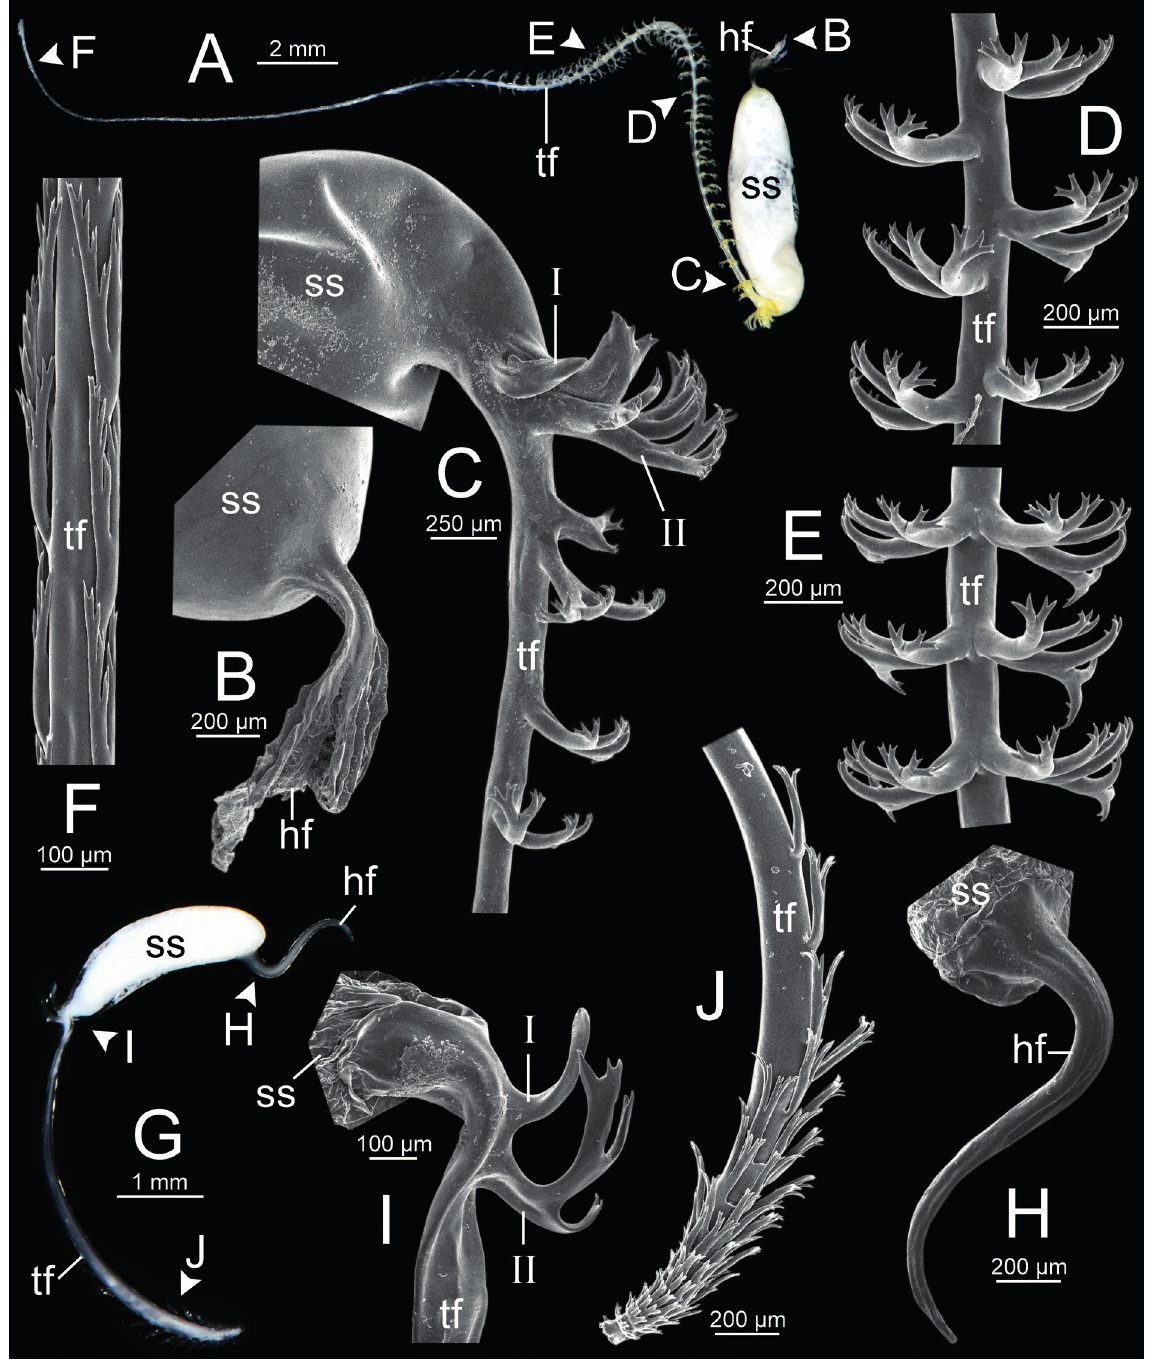
Fig. 6. SEM images of spermatophores. A–F . Sarika khmeriana Pholyotha & Panha sp. nov., paratype (CUMZ 7905). A . General view of spermatophore. B . Head filament. C–F . Detail of tail filament. G–J. S. nana Pholyotha & Panha sp. nov., paratype (CUMZ 7908). G . General view of spermatophore. H . Head filament. I–J . Detail of tail